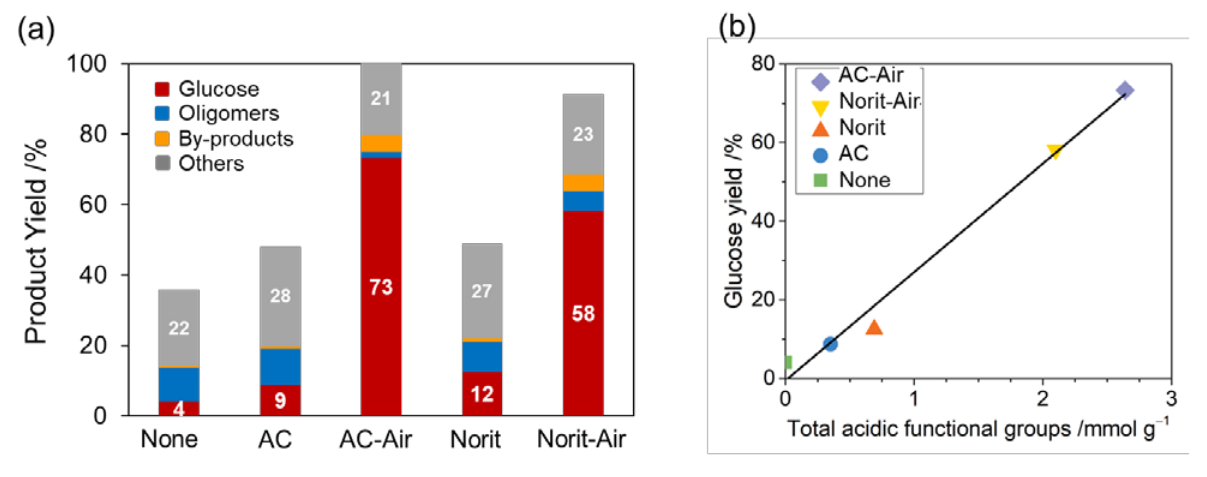
Figure 7. ( a ) Yield of products after hydrolysis of pretreated cellulose adsorbed on various catalysts. ( b ) Correlation between glucose yield and the number of acidic functional groups present on each catalyst. Cellulose treatment conditions: 0.324 g cellulose, 16.2 g H 3 PO 4 , 15 min stirring at room temperature, then 60 min stirring at 60 °C, 0.324 g AC-Air, precipitation with 30 mL H 2 O followed by washing with 300 mL H 2 O. Hydrolysis reaction conditions: wet cellulose + catalyst mixture, 40 mL water, 180 °C, 20 min. By-products include fructose, 5-HMF and levoglucosan. “Others” is the difference between cellulose conversion and identifiable products.